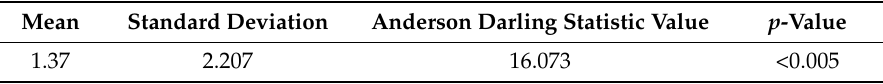
Table 4. Statistics of Algae